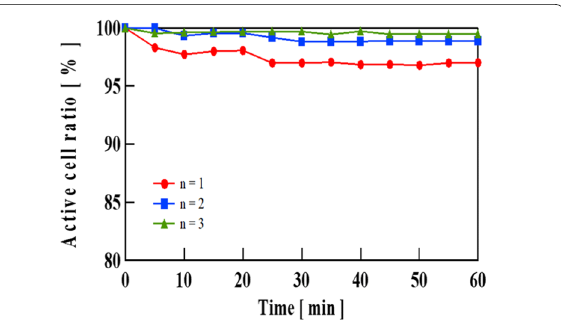
Fig. 6 Variation in active cell ratio of FPB-2 with time, obtained from the results of live/dead assay test. Number of samples (N) was 3